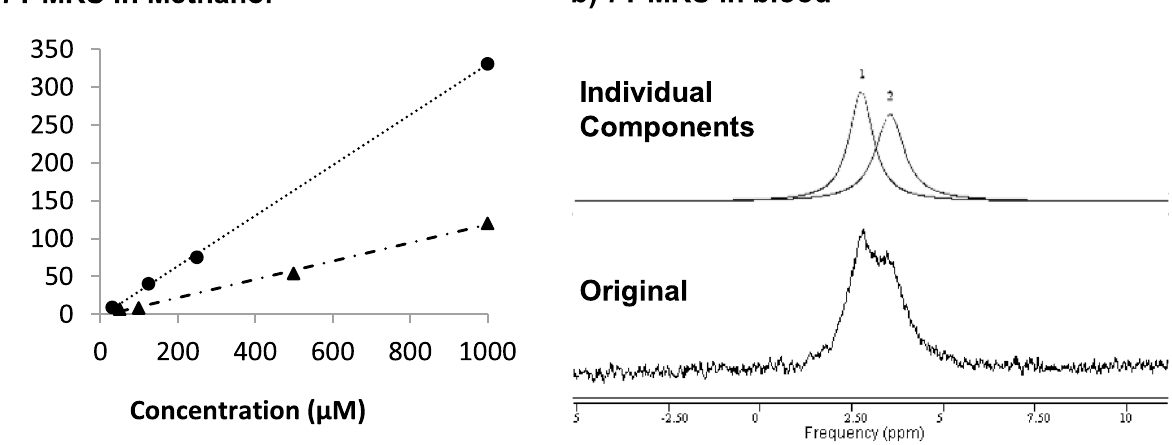
Figure 4. In vitro and ex vivo evaluation of compound c1a as a tracer for 11β-HSD1 activity by 19 F-MRS. (a) Increased 19 F-MRS signal from trifluorinated c1a (circles) vs monofluorinated 11-dehydrodexamethasone (triangles), measured in chloroform solution on the 7T pre-clinical scanner with T R of 0.5 s, 800 repetitions and 400 s acquisition time. The 19 F-MRS signal was linearly correlated with tracer amount (r 2 > 0.99 for both c1a and 11-dehydrodexamethasone) and signal intensity increased linearly with numbers of fluorine atoms per molecule, as demonstrated by trifluorinated c1a giving a signal threefold higher than 11-dehydrodexamethasone. (b) Overlap of 19 F-MRS peaks (upper panel) for c1a and c1b in blood and their resolution (upper panel) by jMRUI software using predefined peak ppm values for c1a (1) and c1b (2).